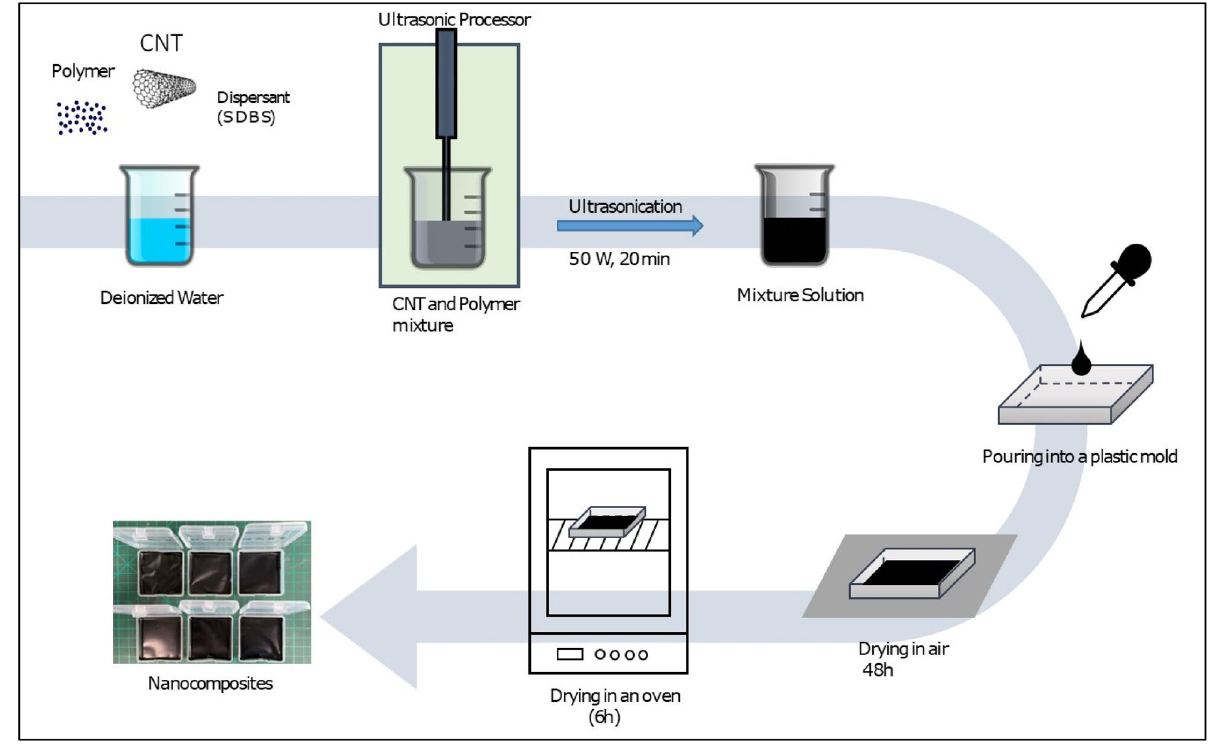
Figure 1. Overall experimental procedure for synthesis of TWCNT/PVA nanocomposite films.